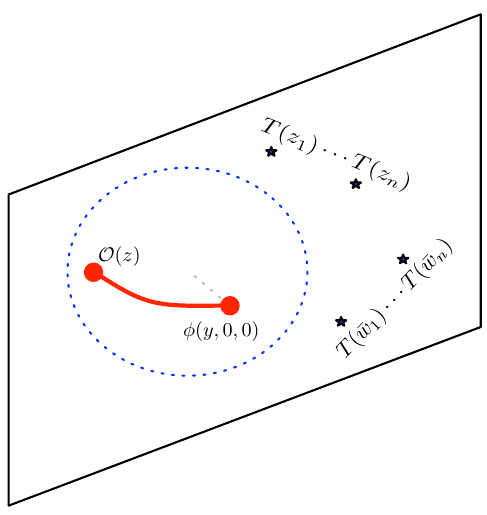
Figure 1 . This (cid:12)gure portrays a bulk-boundary OPE block used to compute the correlator (1.2). The red line denotes the gravitational or Chern-Simons Wilson line, while the blue circle suggests radial quantization around the block, so that it creates a de(cid:12)nite linear combination of Virasoro descendants of the identity. The explicit computation involves line integrals over stress tensor